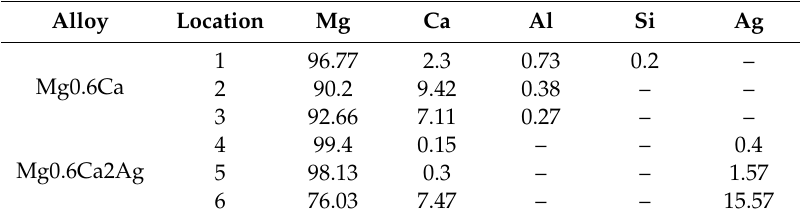
Figure 1. Backscattered electron micrographs of the studied alloys: ( a , b ) Mg0.6Ca and ( c , d ) Mg0.6Ca2Ag. Table 2. Local EDS point analysis as per Figure 1.